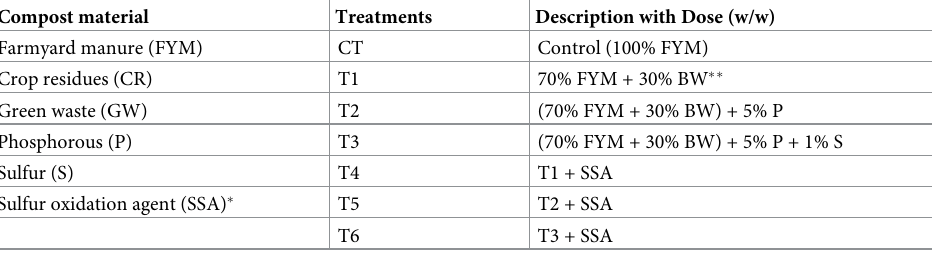
Table 1. Fertilizer strategies, description, and their doses. Compost